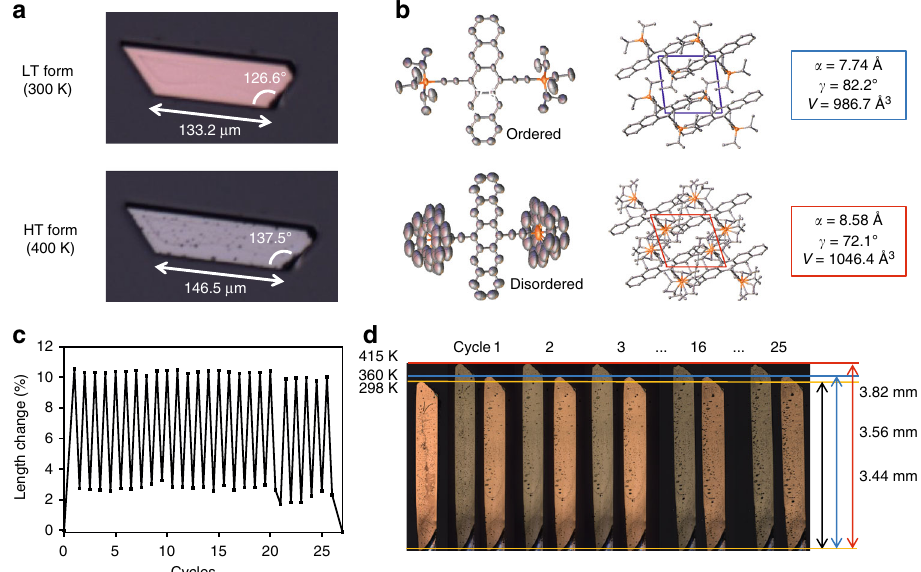
Fig. 5 Martensitic transition in TIPS-pentacene single crystals showing the shape memory effect. a Length and angle changes before (300 K) and after (400 K) martensitic transition. b Order-to-disorder transition of the side chain. The molecular structure shown for the HT form is the overlap of three conformations, similar to the ditBu-BTBT system. The unit cell parameters that experienced the largest changes are shown. Hydrogen atoms are omitted for clarity. c Pronounced shape memory effect in a TIPS-pentacene single crystal displaying a length change of more than 10% for 26 cycles. Throughout the entire experiment, the sample showed precise and highly repeatable mechanical expansion and contraction. d POM image of the TIPS-pentacene single crystal tested for the shape memory effect. After 26 thermal cycles tested over a period of 8 weeks, structural integrity of the mm-sized